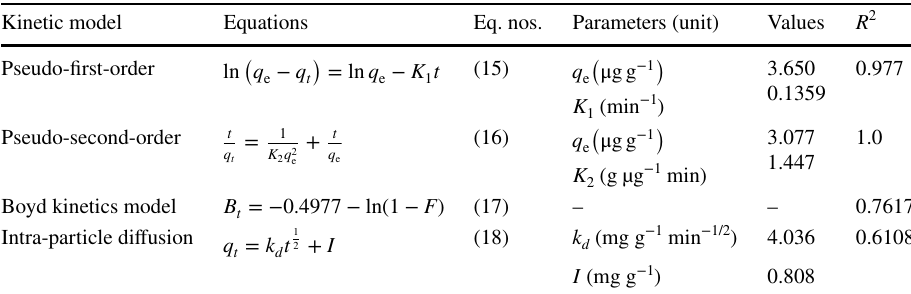
q t is the adsorption capacity at time t ; K K 1 and 2 are the first-order and second-order rate constants, respec- tively, and B t against time (min) F represents the fraction of solute adsorbed at any time t (min), as calcu-